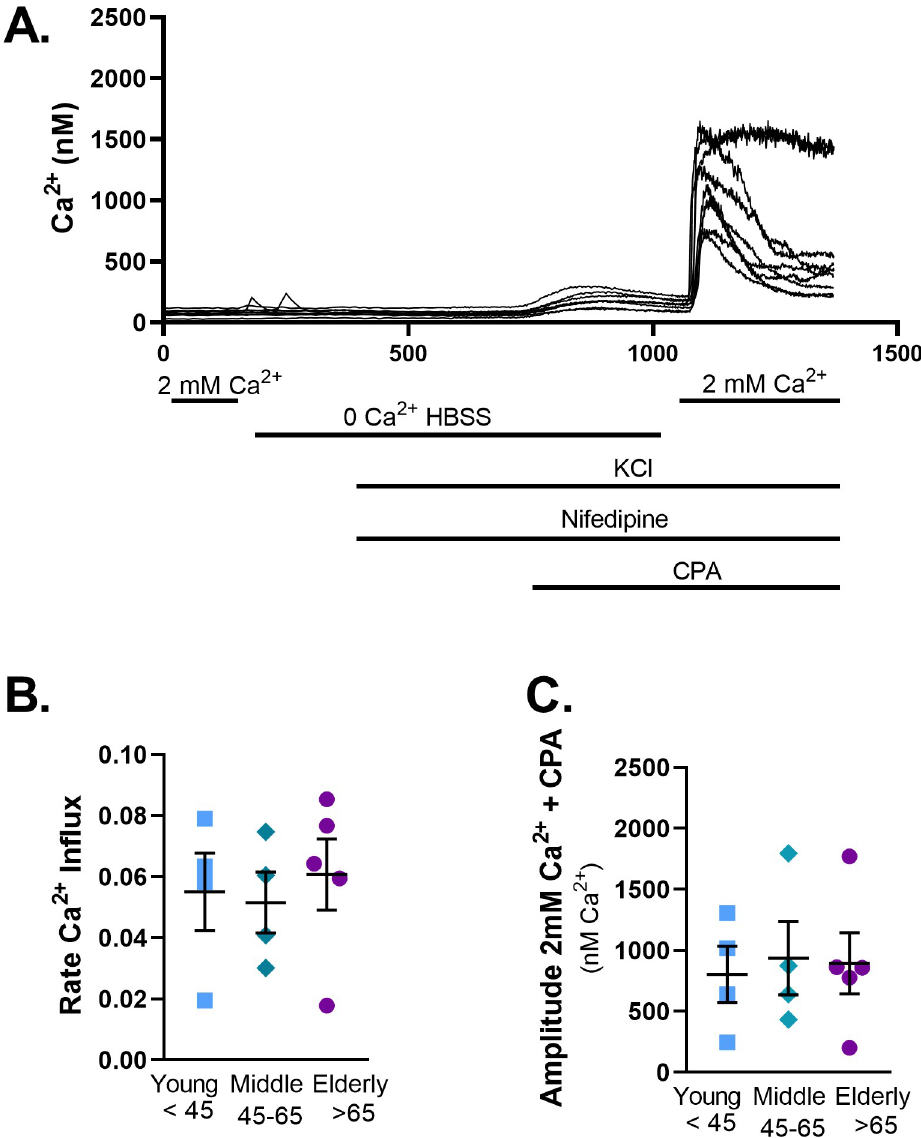
Fig 7. Store Operated Calcium Entry (SOCE) is not changed with age. Representative traces for SOCE in ASM (A). In the representative trace individual lines show the variations in cellular responses for a single well measured. The rate of Ca 2+ influx was not changed with age (B). Similarly, the amplitude (C) of Ca 2+ influx was not changed with age. Data represents mean ± SEM from N of 4–5 patients. � indicates significant effect (p � 0.05).